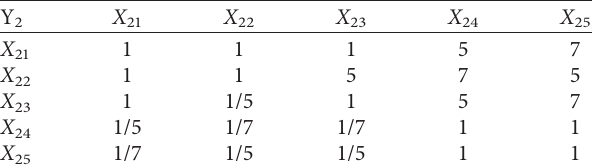
Table 6: Judgment matrix of the production phase.